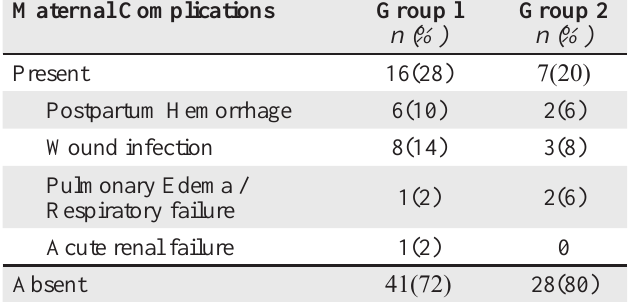
Table 4 : Maternal complications according to the admission status